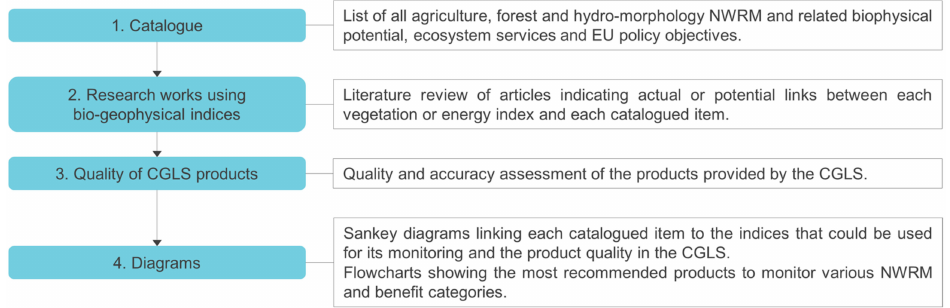
Figure 1. Flowchart showing the steps followed to determine the most recommended vegetation and energy indices provided by the Copernicus Global Land Service for monitoring natural water retention measures and their benefits.